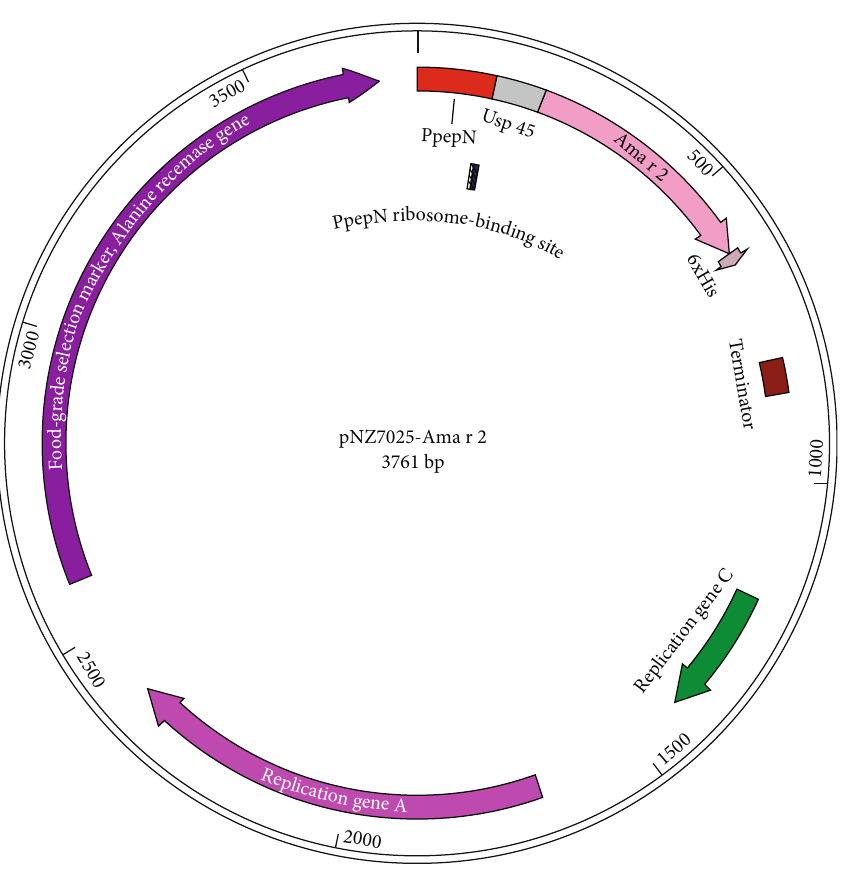
Figure 1: A schematic diagram of the L. lactis NZ1330 expression plasmid, pNZ7025-Ama r 2. Table 1: The primers used in site-directed